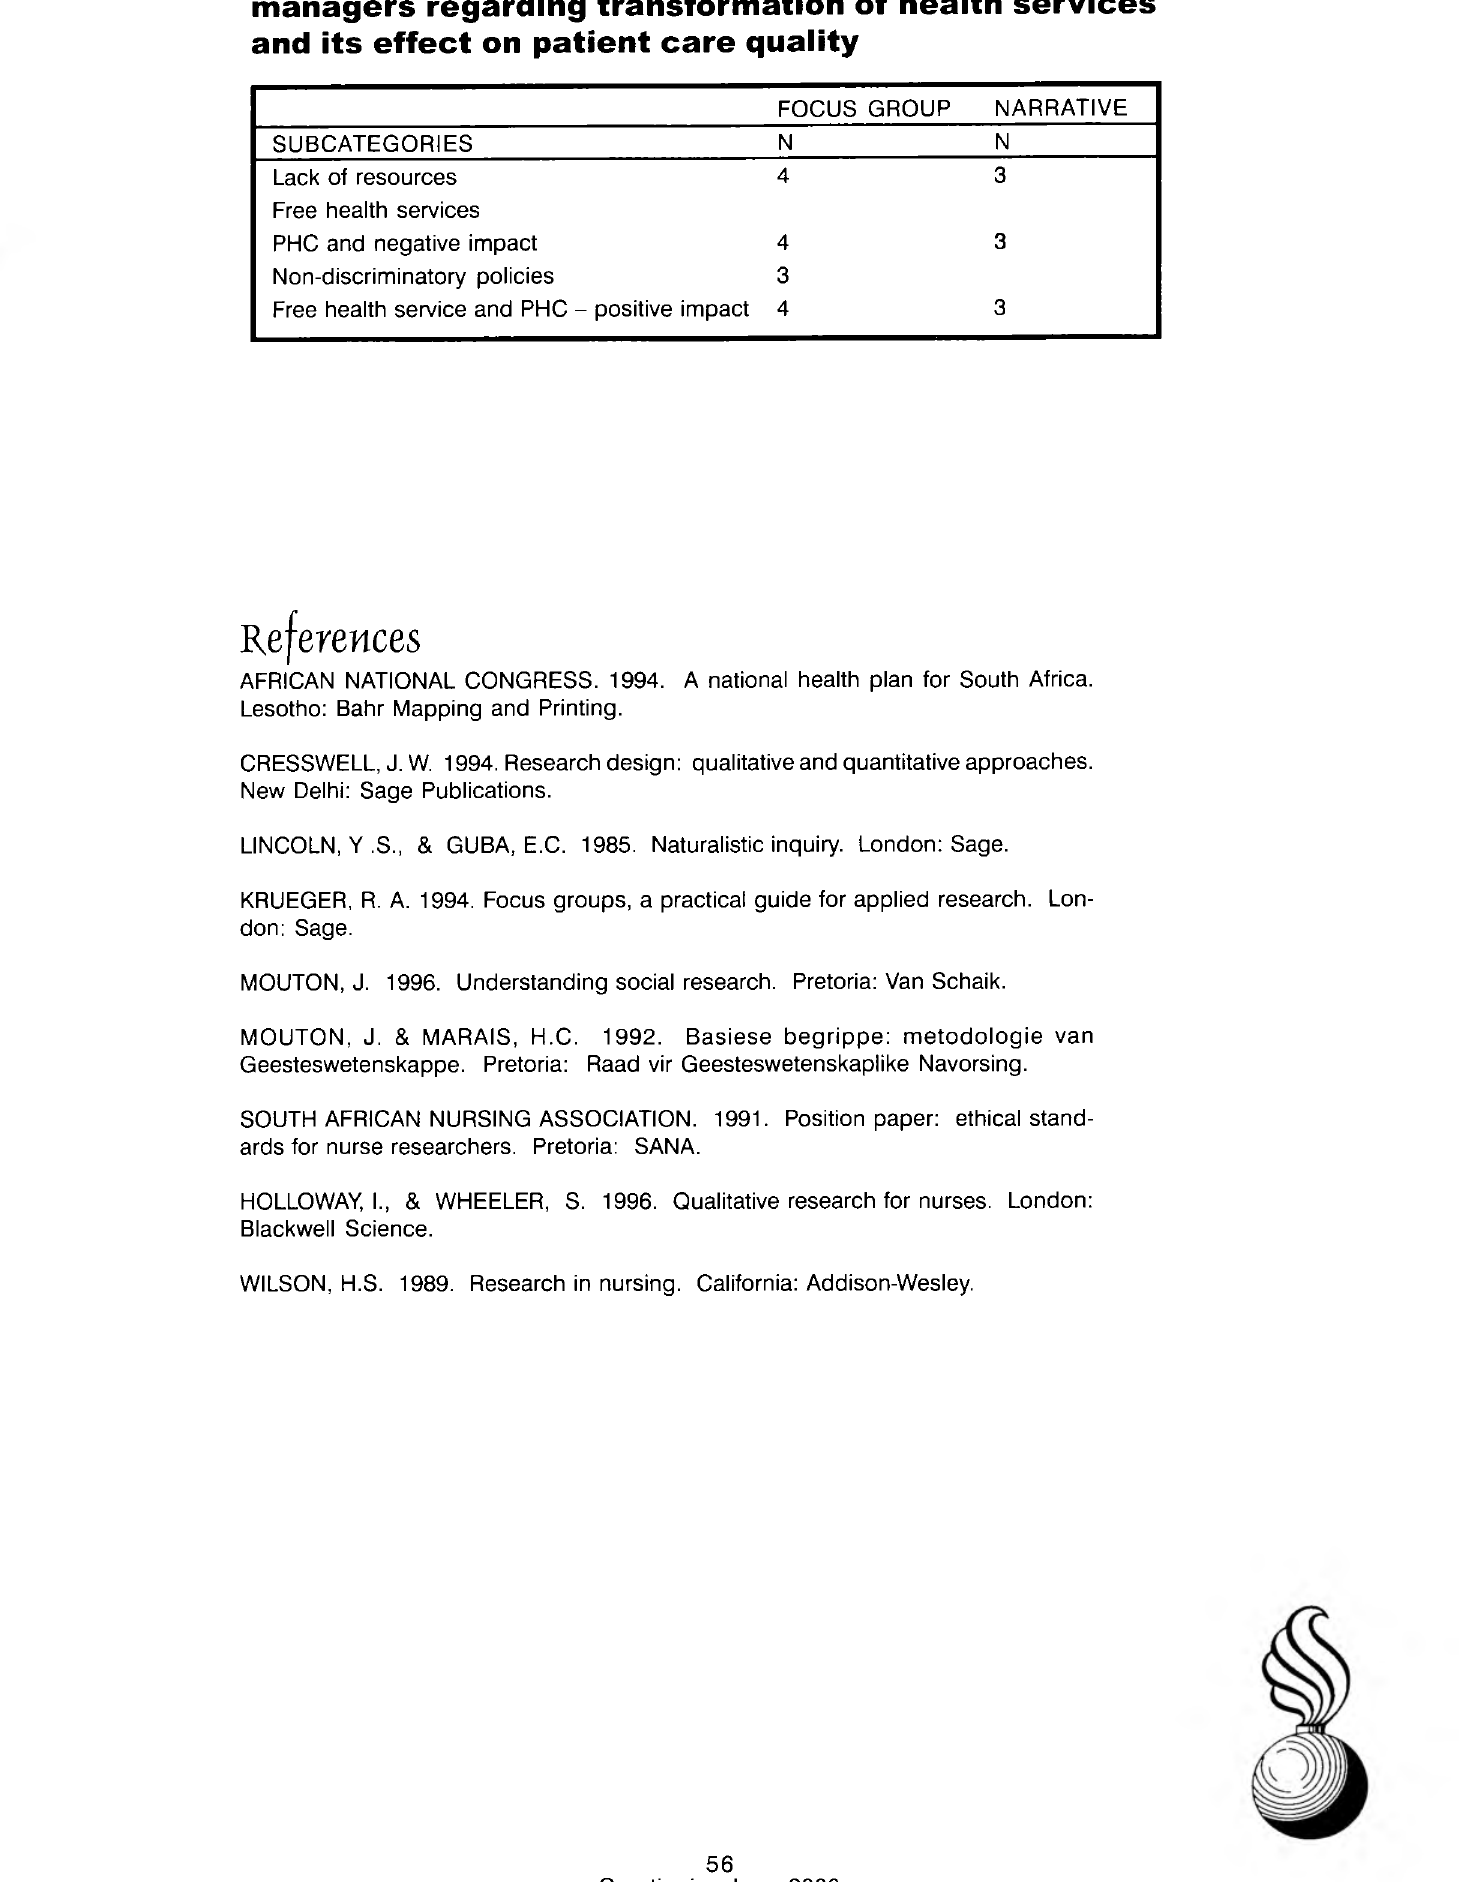
Table 4: D istribution of positive and n eg ative exp erien ces and perception s of nursing s e rv ic e m anagers regarding tran sfo rm ation of health s e rv ic e